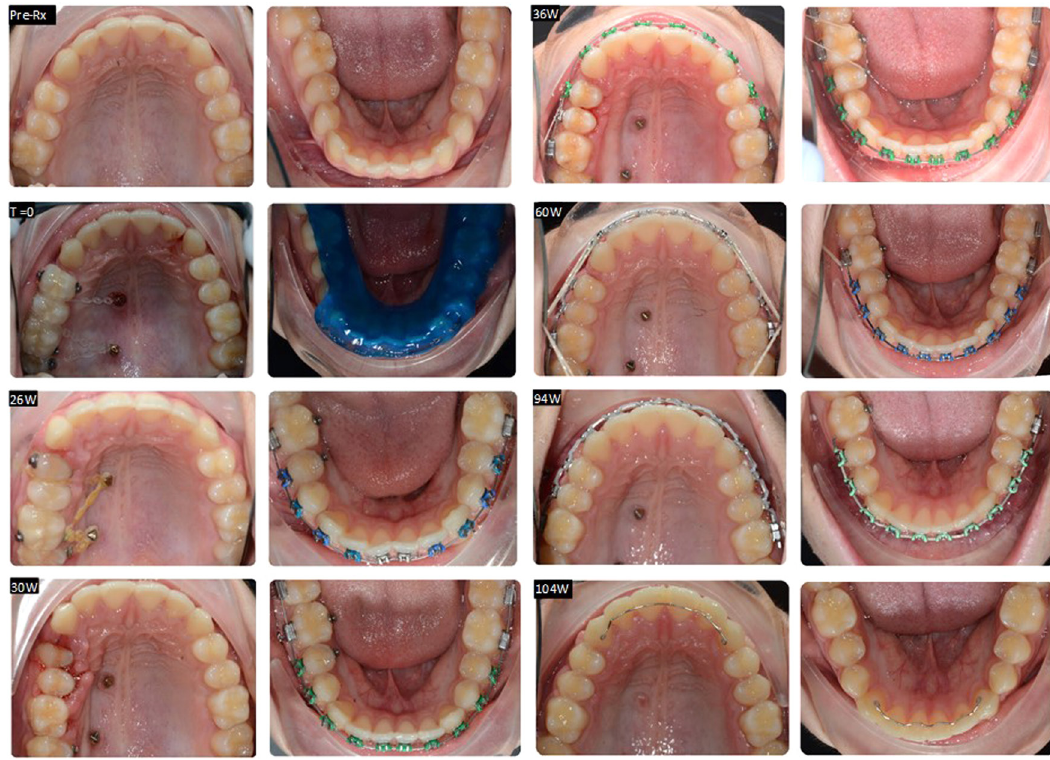
Figure 7. Treatment progression shown in occlusal photographs (time-period in weeks).